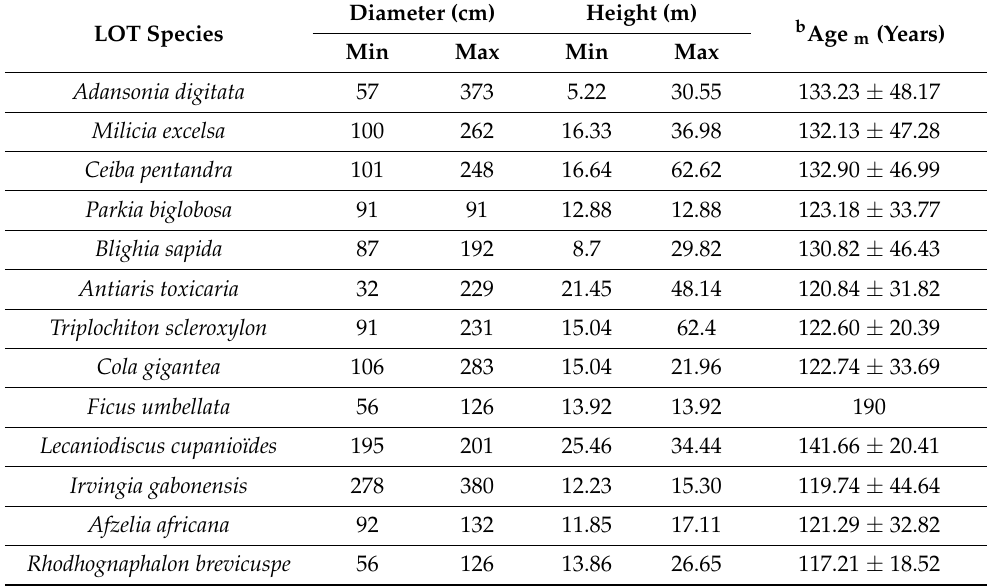
Table 3. Dimensions and estimated age of LOTs (estimation has been made according to the reign of kings).